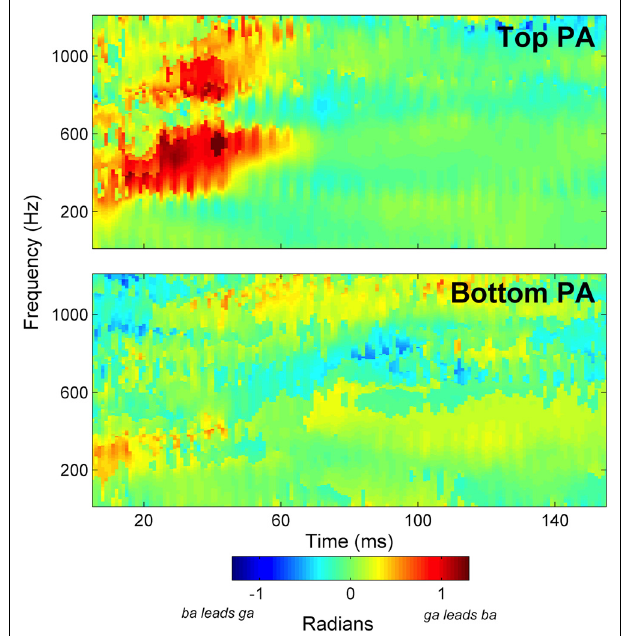
FIGURE 2 | Group average cross-phaseograms are presented for the Top phonological awareness (PA) and Bottom PA groups. TheTop PA more strongly codes the difference between the [ba] and [ga] stimuli, as indicated by the large red–orange swatches in response to the CV